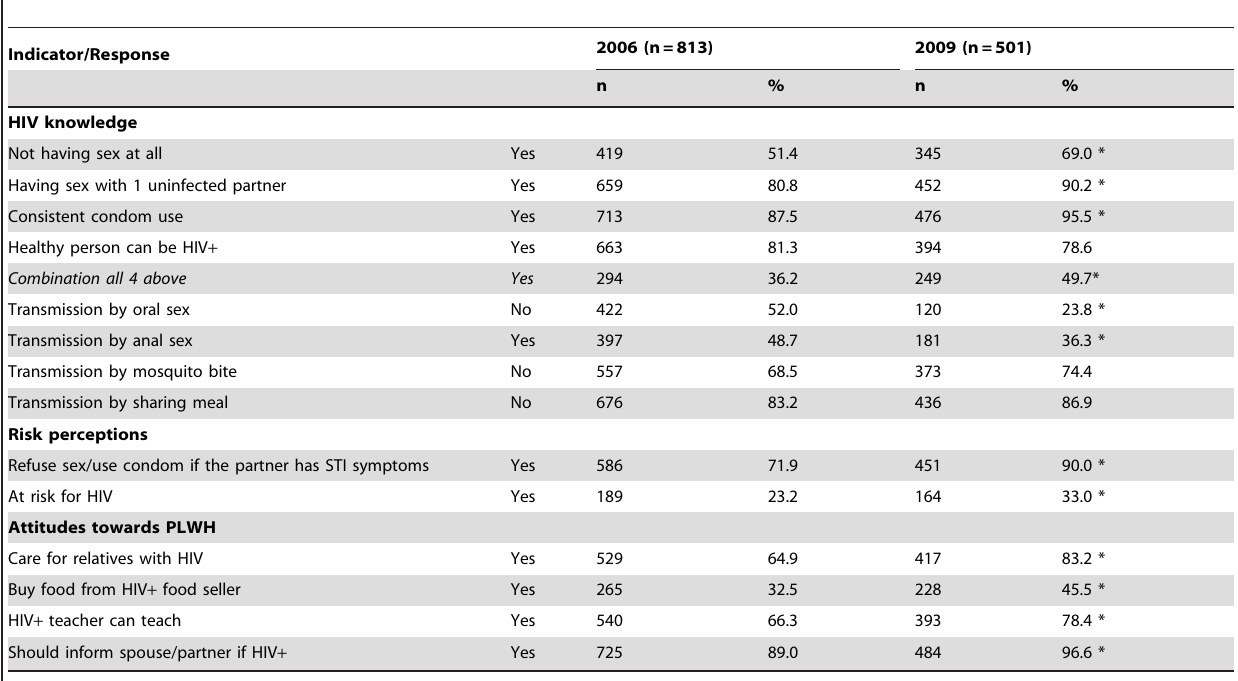
Table 2. HIV knowledge, risk perceptions, and attitudes among community and factory youth.